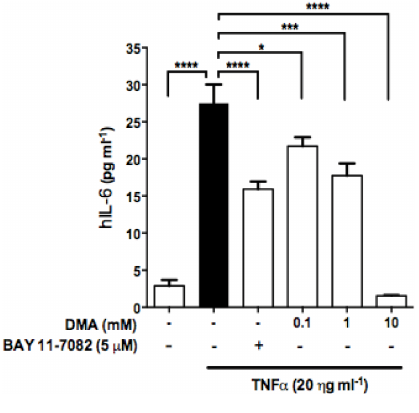
Figure 3. DMA inhibits IL-6 secretion in JEG-3 cells. ELISA was performed to determine IL-6 levels in JEG-3 cell superna- tants after incubation with DMA and BAY 11-7082 in TNF α -stimulated JEG-3 cells. Data shown are means ± SEM of at least three independent experiments done in